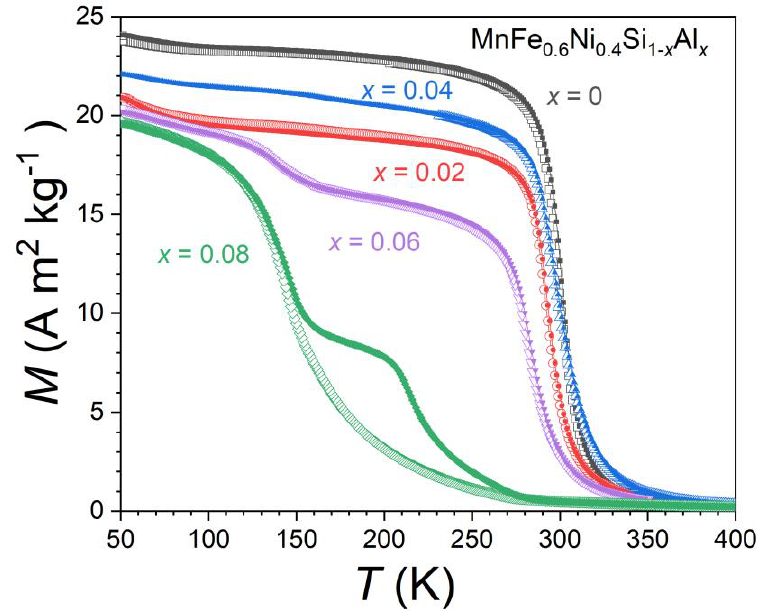
Figure 2. M ( T ) curves for MnFe 0.6 Ni 0.4 Si 1- x Al x compounds measured upon heating (full symbols) and cooling (open symbols) in an applied field of μ 0 H = 0.05 T.